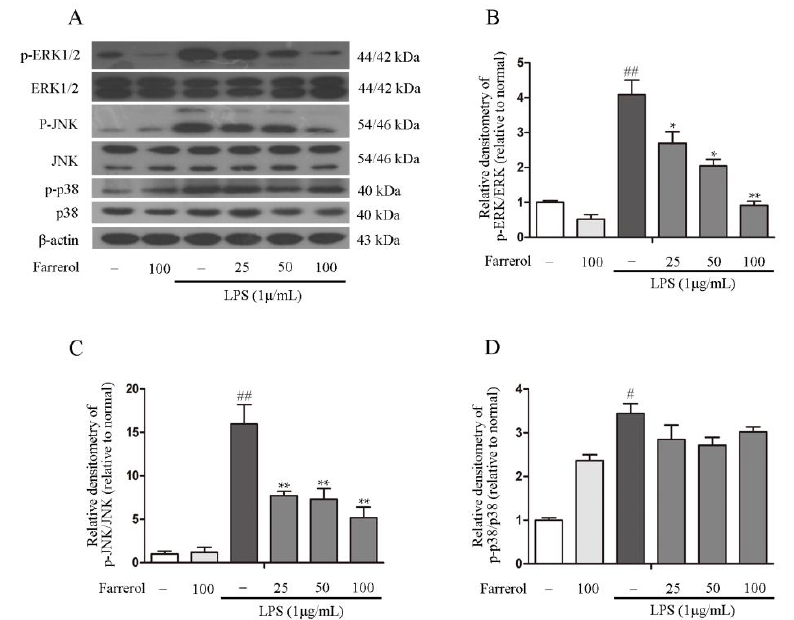
Figure 7. Farrerol inhibits ERK1/2 and JNK phosphorylation in LPS-stimulated RAW246.7 cells. Pretreating cells with different concentrations of Farrerol (25, 50, and 100 μM) for 1 h, then cells were stimulated with LPS (1 μg/m L) for 1 h. The phosphorylation and total forms of the MAPK signaling pathways were detected via western blot ( A ). The phosphorylation ratio of ERK1/2, JNK and p38 were quantified ( B – D ) ( n = 3). # p < 0.05 and ## p < 0.01 compared to the control group, * p < 0.05 and ** p < 0.01 compared to the LPS group, and statistical significance was determined by ANOVA.